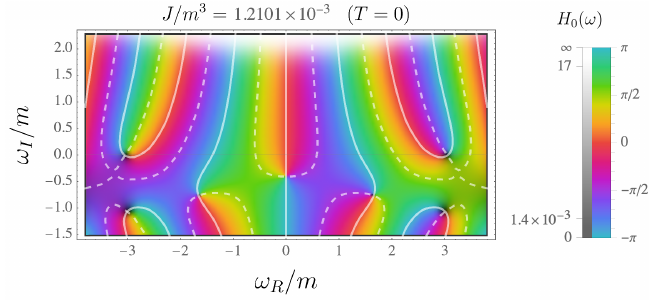
Figure 6 . Example of complex function H 0 ( ω ) in complex ω plane: ω = ω R + iω I . The white solid lines show Im H 0 ( ω ) = 0 . The white dotted lines show Re H 0 ( ω ) = 0 . Points where the solid and dotted lines cross correspond to the zeros or the poles of H 0 ( ω )